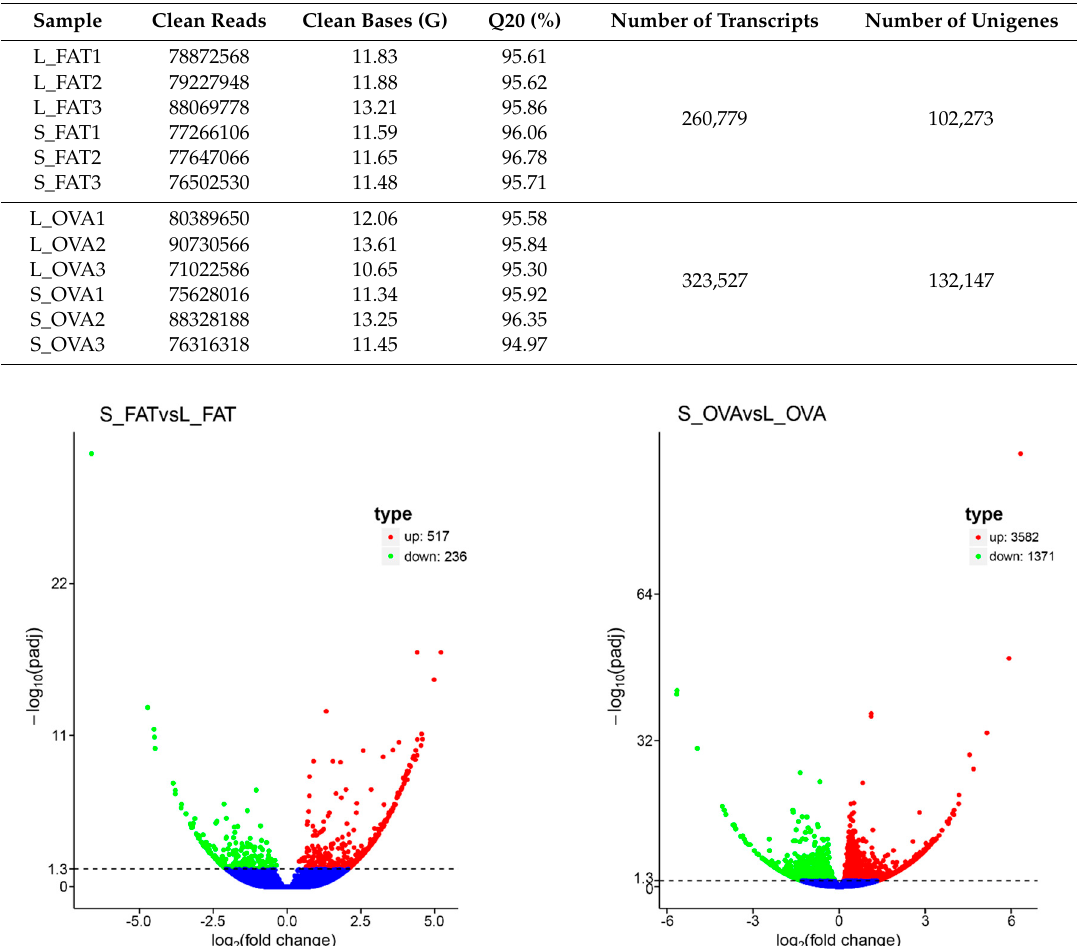
Table 1. Summary of RNA-seq metrics from L. migratoria transcriptomes for ovaries and fat bodies under both long and short photoperiods.